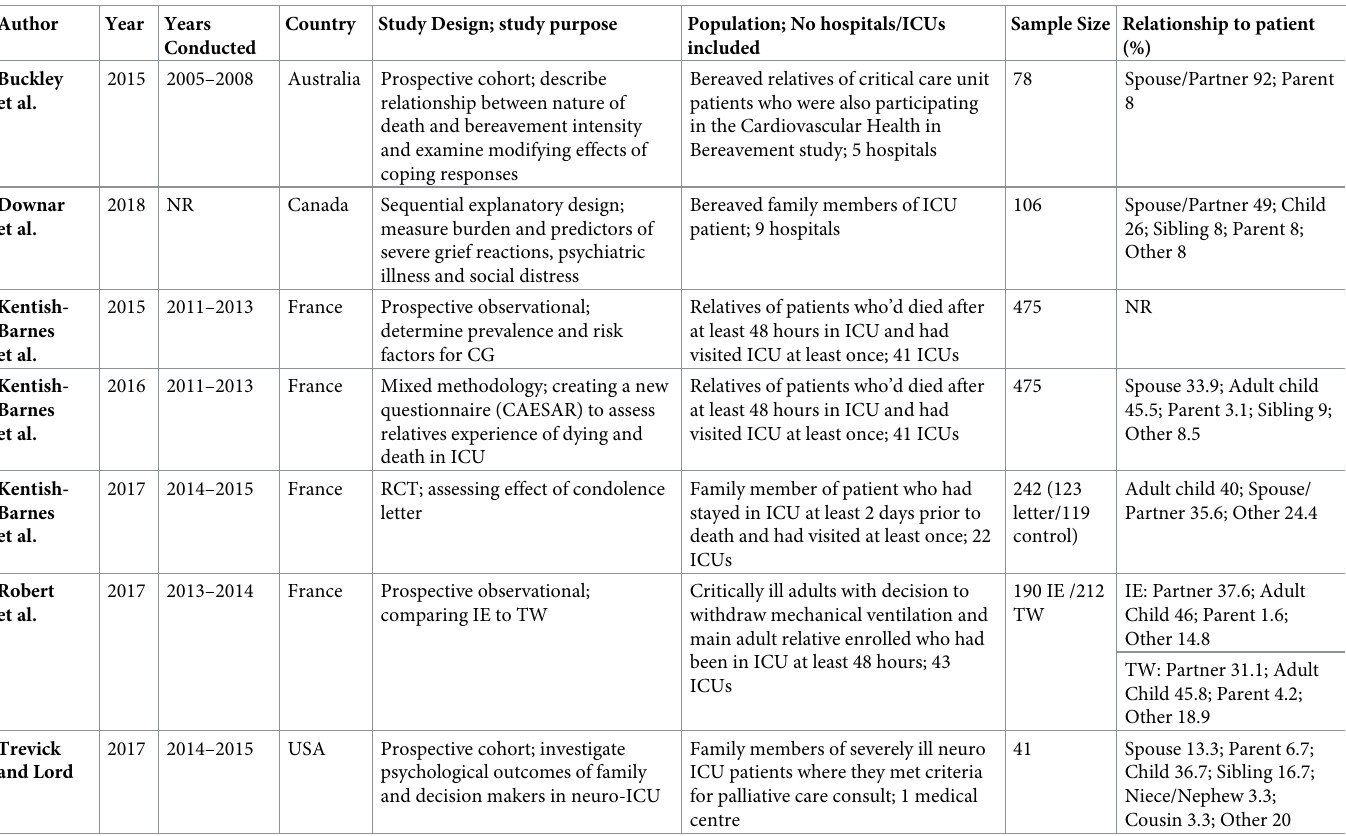
Table 1. Publication data, study design information and details concerning the population for the 7 studies selected which assess potential risk factors for compli- cated